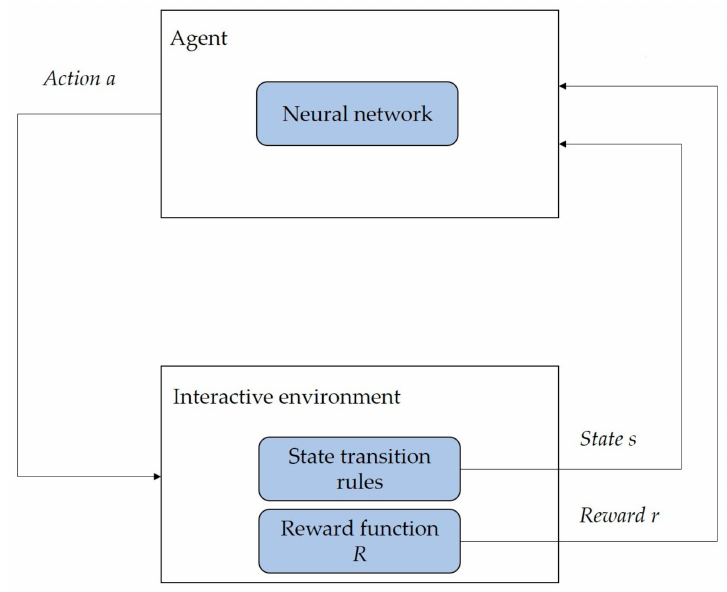
Figure 2. Explanation of the basic principles of